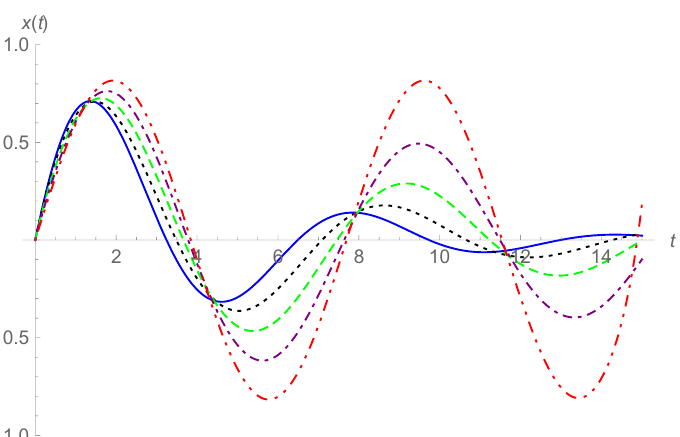
Figure 2. Curves of x ( t ) for m = k = 1, c = 0.5 and for α = 1 (solid line), 1.25 (dotted line), 1.5 (dashed line), 1.75 (dotted-dashed line), and 2 (dotted-dotted-dashed line).